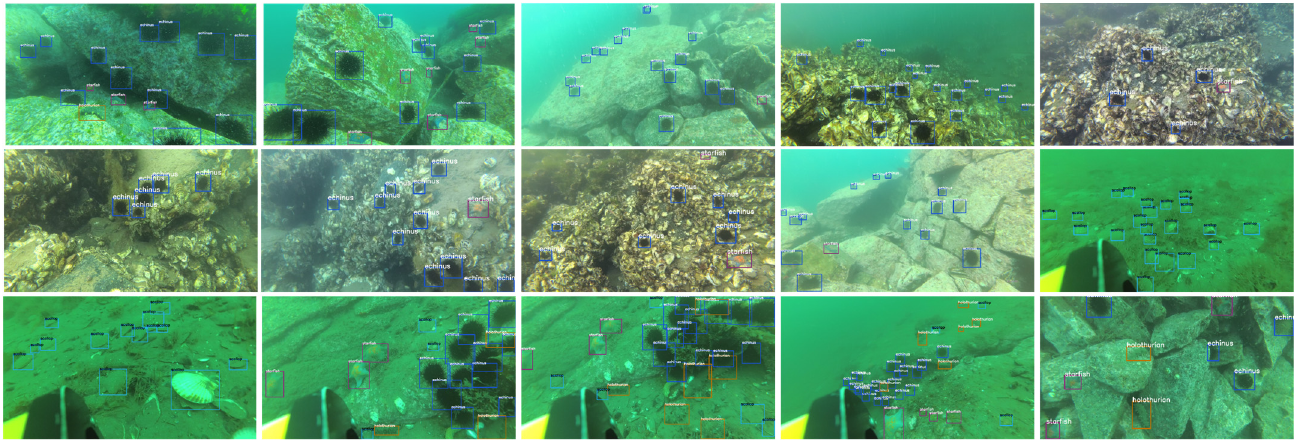
Figure 3. The detection results of FFT_YOLOX model.